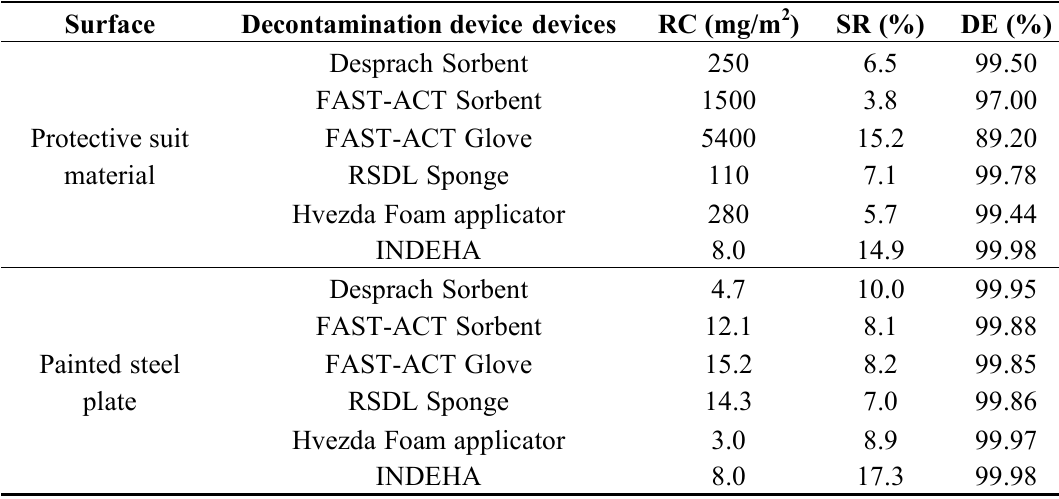
Table 3. Average values for residual surface contamination (RC), relative standard deviation (SR) and decontamination efficiency (DE) for o-cresol at an initial contamination level of 50 g/m 2 (permissible residual contamination 100 mg/m 2